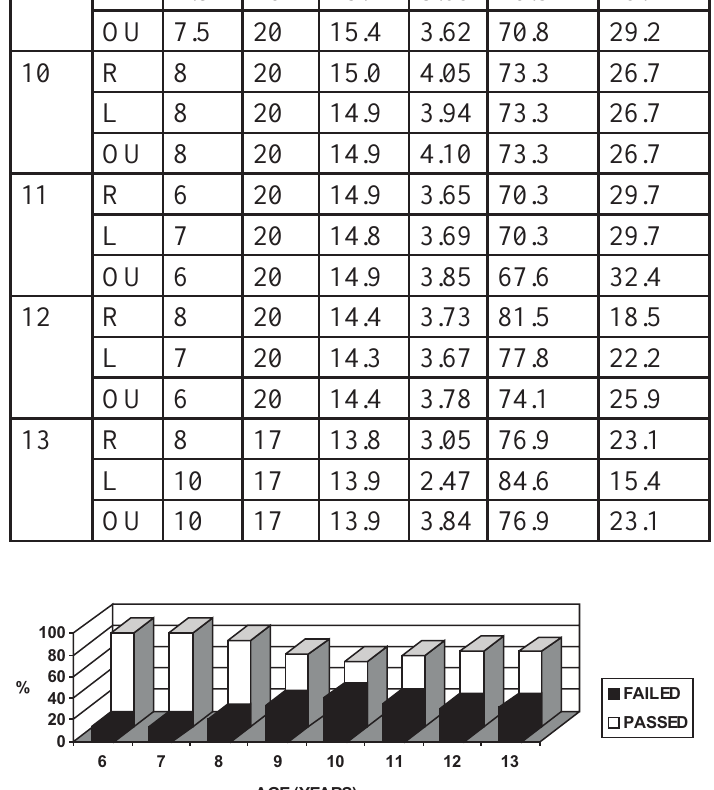
FIGURE 1: PROFILE OF SUBJECTS (N=264)